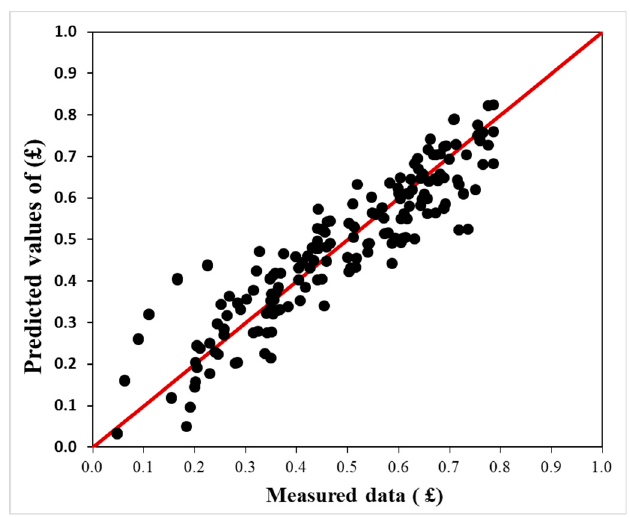
Figure 31. Measured £ versus Predicted ones from Equation (2).